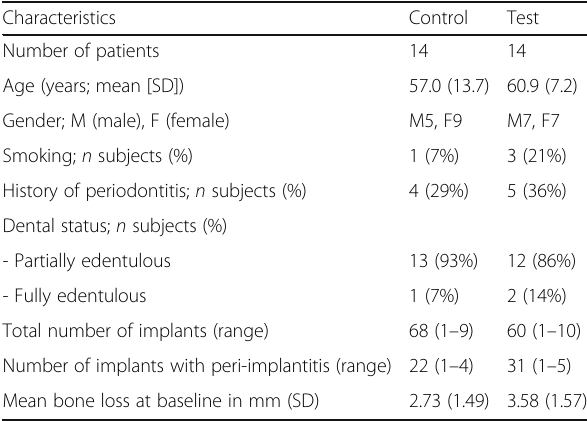
Table 1 Characteristics of included patients/implants